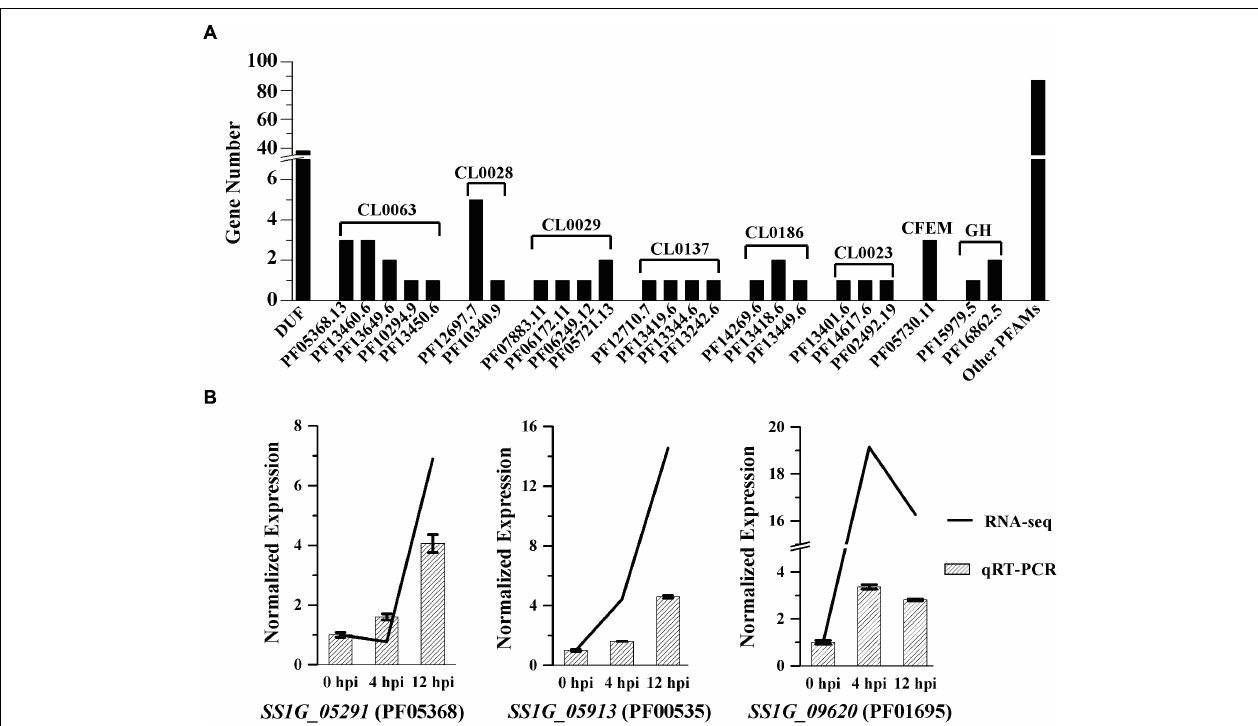
FIGURE 6 | Protein family (Pfam) annotation of the unclassified DEGs in S. sclerotiorum induced by C. minitans . (A) Gene count annotated into the Pfam family of the unclassified DEGs. DUF, protein of unknown function; PFxxx, protein family list in the Pfam database; CLxxx, the clan family based on the Pfam databse; CFEM, a fungal specific cysteine rich domain; GH, domain of glycoside hydrolase. (B) Valuation of the three high regulated DEGs of SS1G_05291 , SS1G_05913, and SS1G_09620 based on qRT-PCR during the early interaction stages of 0, 4, and 12 hpi in S. sclerotiorum induced by C. minitans . The primer pairs of SS1G_05291 , SS1G_05913, and SS1G_09620 were detail listed in Supplementary Table S7